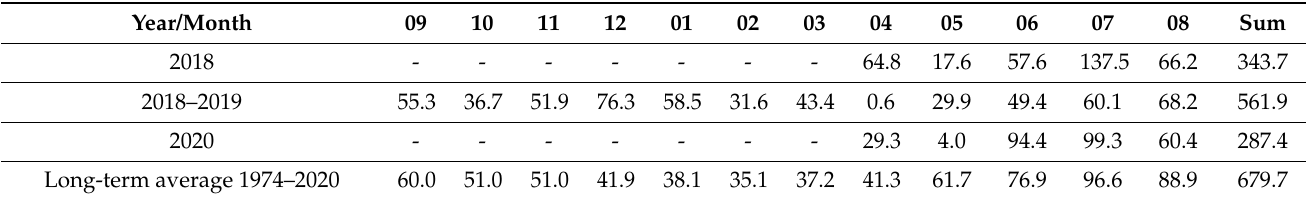
Table 2. Precipitation (mm) during the spring wheat vegetation period (April–August) in 2018 and 2020 and the winter wheat vegetation period (September–August) in 2018–2019, Kaunas Meteorologi- cal Station,